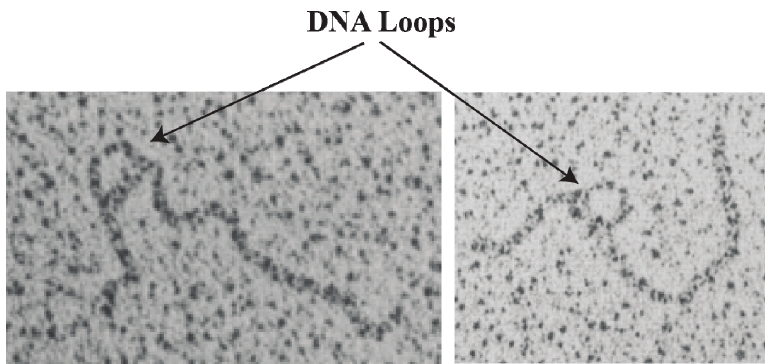
Figure 10. Electron micrograph of LacI-mediated DNA loop. The arrow points to the DNA loop of 95 bp in the ( ) DNA. One end of the DNA is 130 bp from the loop and the other end is 380 bp (reproduced with permission from Cold Spring Harbor Laboratory Press